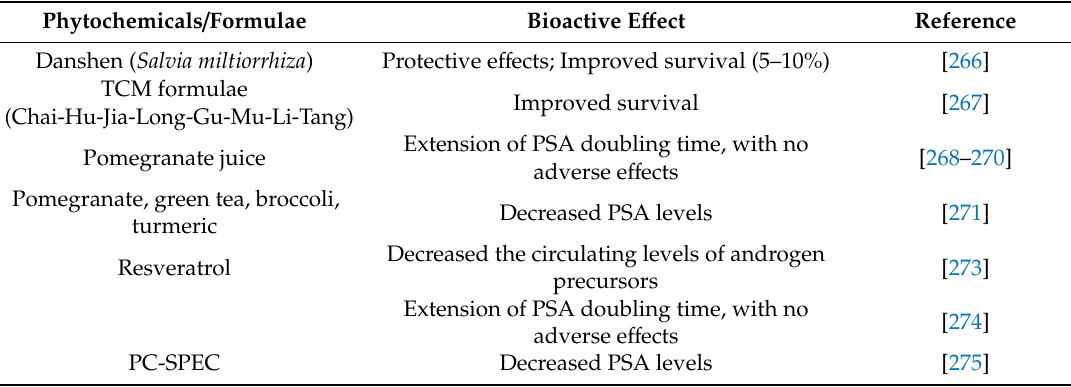
Table 5. Clinical trials showing the anti-prostate cancer potential of plant-derived